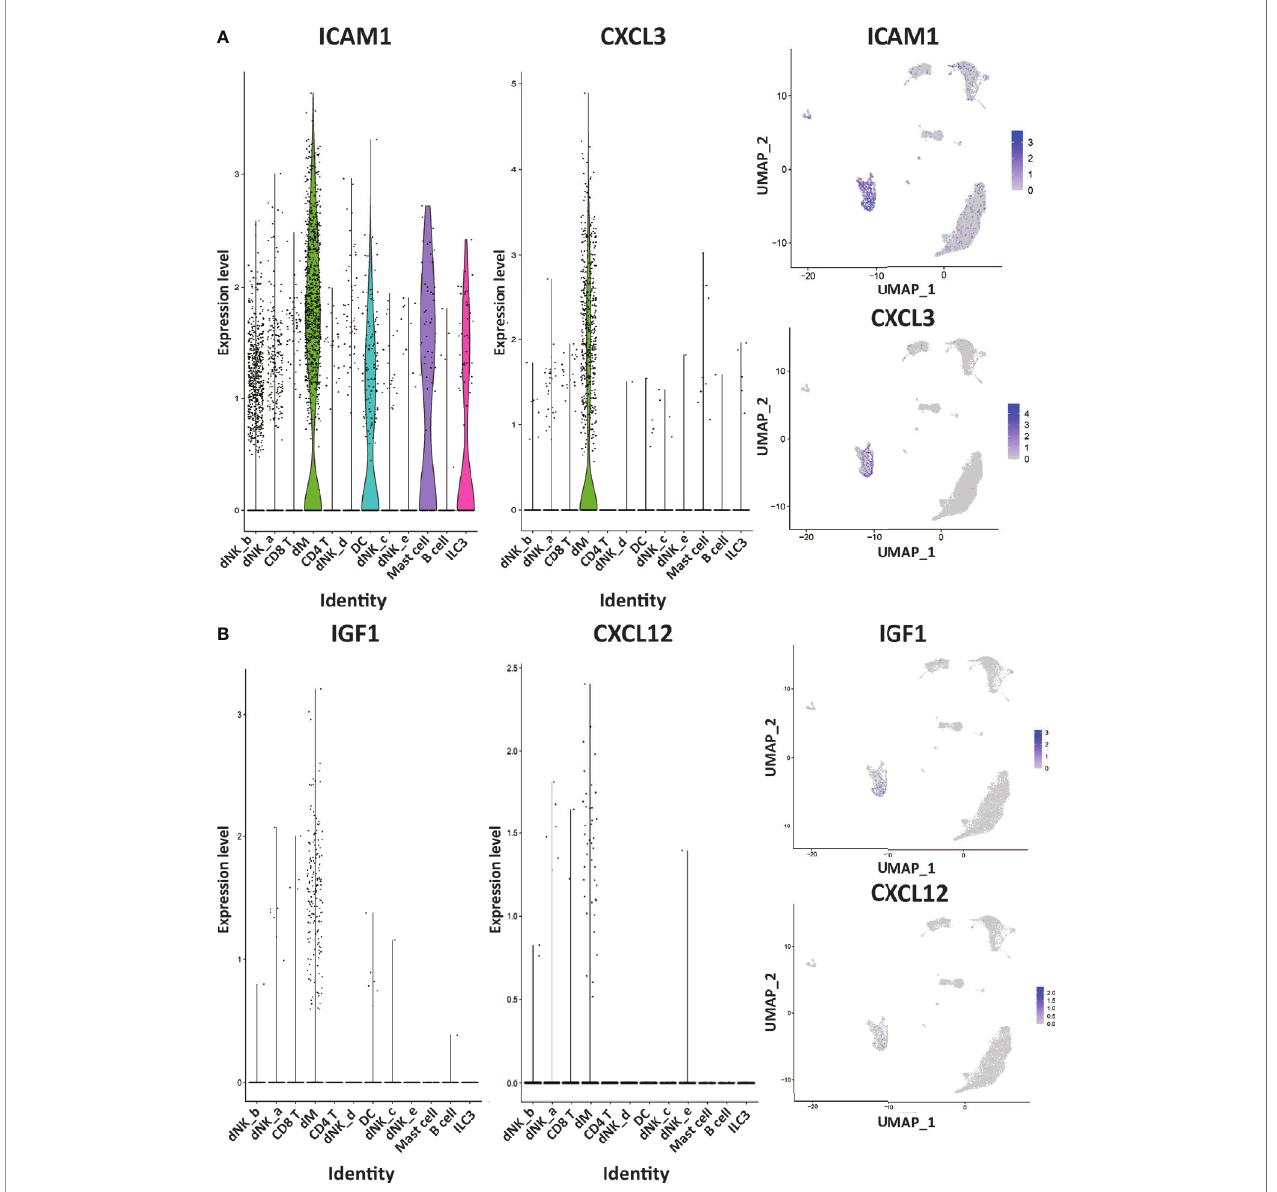
FIGURE 3 | The expression of DEGs in the immune cells of normal decidua. (A) The violin plots and the UMAP visualization maps showing the expression of two down-regulated DEGs (ICAM1 and CXCL3) in the immune cells of normal decidua. (B) The violin plots and the UMAP visualization maps showing the expression of two up-regulated DEGs (IGF1 and CXCL12) in the immune cells of normal decidua. dM, decidual macrophages; dNK, decidual natural killer cells; ILC, innate lymphoid cells; DC, dendritic